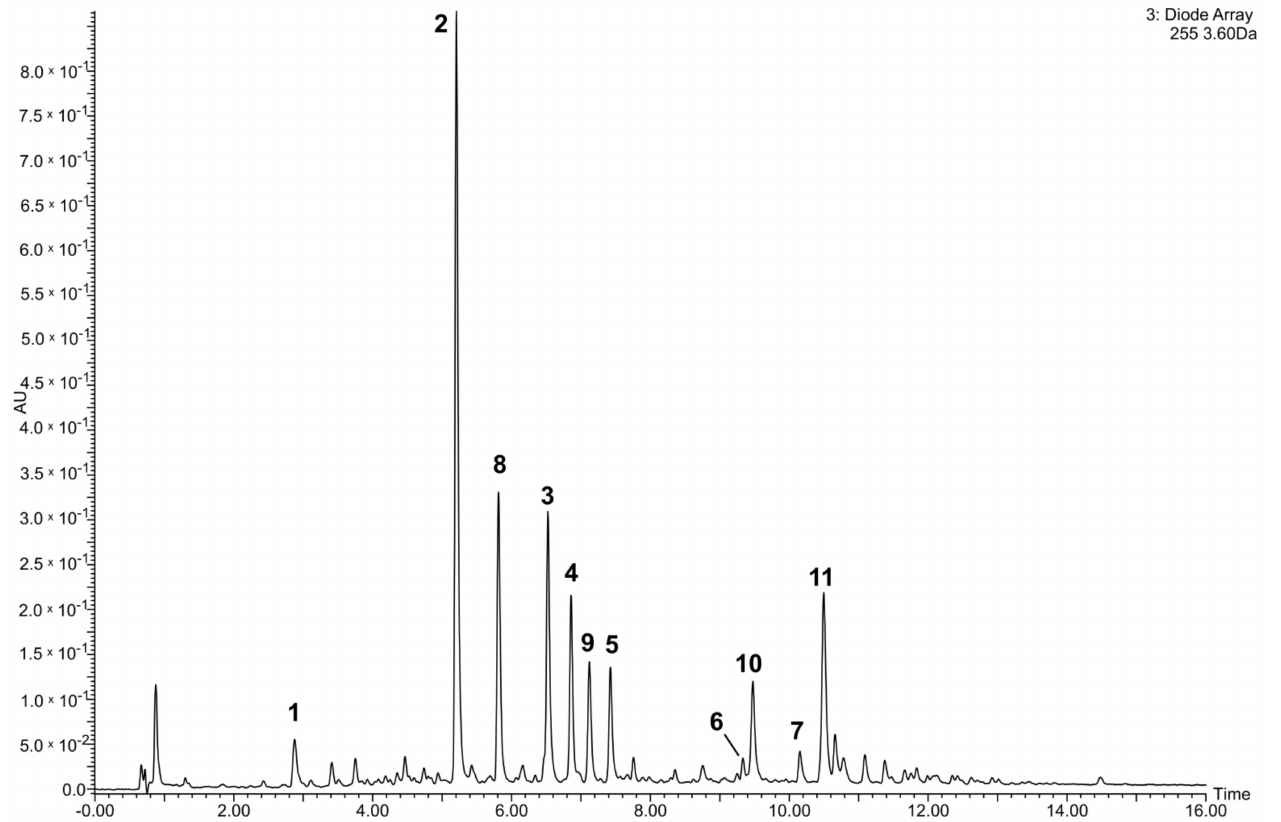
Figure 2. Ultra-high-performance liquid chromatographic-photodiode array chromatogram ( λ = 255 nm) of the phenolic fraction of lentil aerial parts (AU—absorbance units). 1 —quercetin 3- O - β - D -glucopyranosyl-(1 → 2)- β - D -galactopyranoside- 7- O - β - D -glucuropyranoside; 2 —quercetin 3- O -[(6- O - E -caffeoyl)- β - D -glucopyranosyl-(1 → 2)]- β - D -galactopyranoside-7- O - β - D -glucuropyranoside; 3 —quercetin 3- O -[(6- O - E - p -coumaroyl)- β - D -glucopyranosyl-(1 → 2)]- β - D -galactopyranoside- 7- O - β - D -glucuropyranoside; 4 —quercetin 3- O -[(6- O -E-feruloyl)- β - D -glucopyranosyl-(1 → 2)]- β - D -galactopyranoside-7- O - β - D -glucuropyranoside; 5 —kaempferol 3- O -[(6- O - E -feruloyl)- β - D -glucopyranosyl-(1 → 2)]- β - D